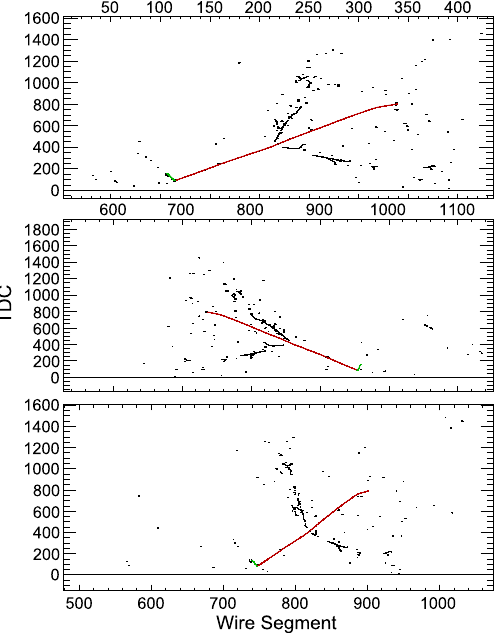
Fig. 36 Event display for an n − ¯ n signal event, n ¯ n → n π 0 π 0 π + π − . The vertical axis is TDC value, and the horizontal axis is wire number. The bottom view is induction plane one, the middle is induction plane two, and the top is the collection plane. Hits associated with the back- to-back tracks of the charged pions are shown in red. The remaining hits are from the showers from the neutral pions, neutron scatters, and low-energy de-excitation